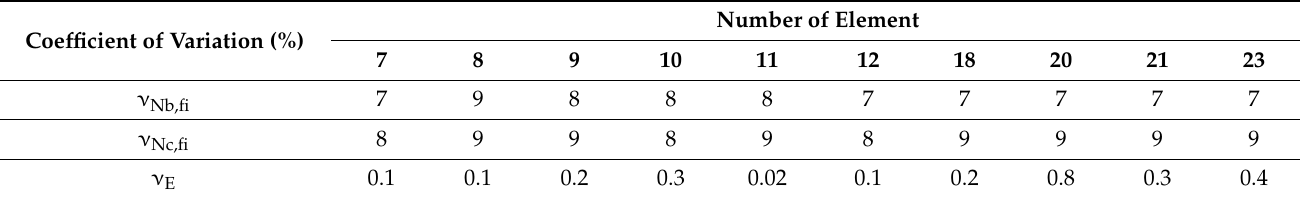
Table 2. Coefficient in variations of bearing capacities according to advanced probabilistic models.